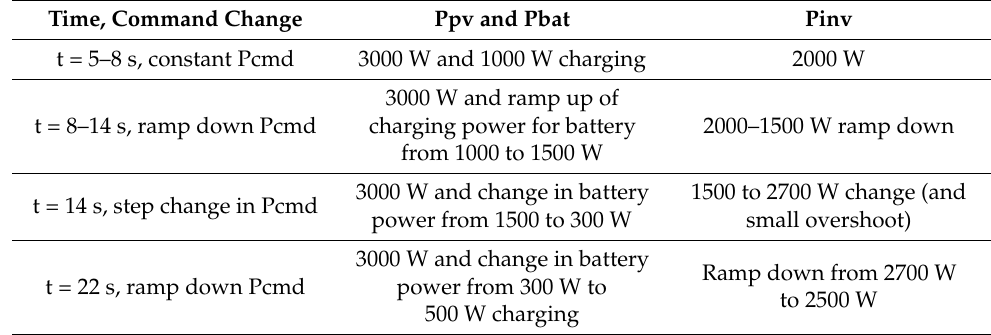
Table 3. Real power-tracking performance.